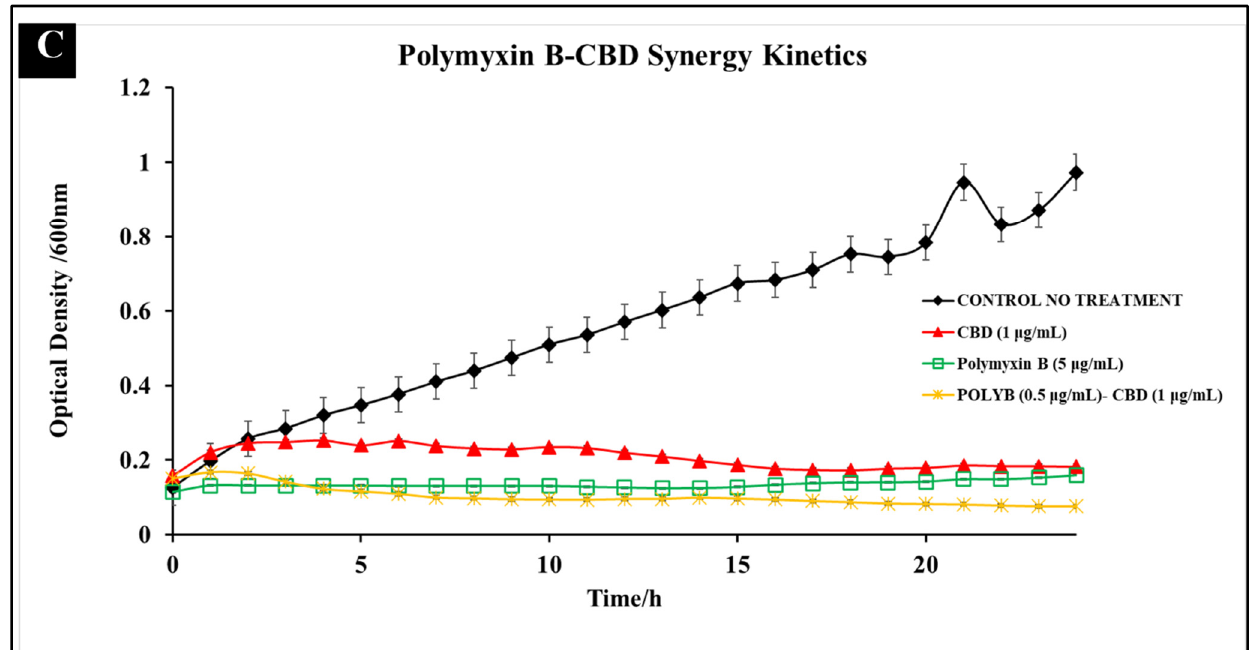
Figure 6. Comparative efficacy of CBD-antibiotic co-treatment and MIC antibiotic mono-treatment against S. typhimurium . Three co-treatments examined include ampicillin (0.5 μ g/mL)-CBD (1 μ g/mL) ( A ), kanamycin (5 μ g/mL)-CBD (1 μ g/mL) ( B ), and polymyxin B (0.5 μ g/mL)-CBD (1 μ g/mL) ( C ).